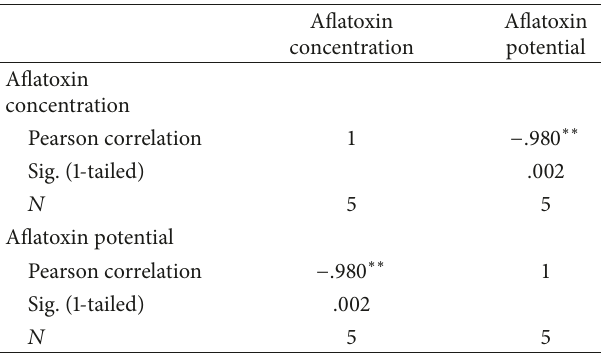
Table 6: Correlations analysis between aflatoxins concentration and aflatoxigenic potential of